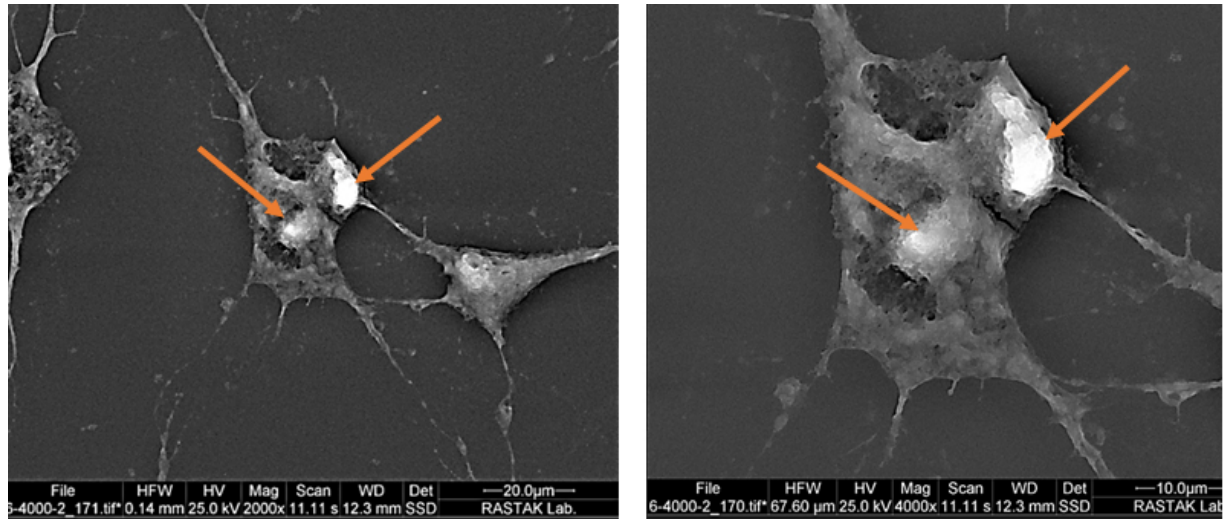
Fig. 3. Scanning electron microscopic images of differentiated cells . As shown in 2000 × and 4000 × magnifications, network con- nections and double nuclei (shown with two orange arrows) were seen in the cells showed efficient differentiation (Scale bare; 20 µ m and 10 µ